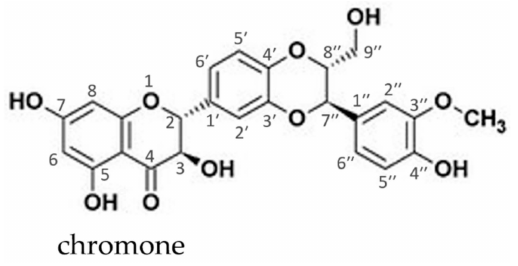
Figure 1. Molecular structure of silybin